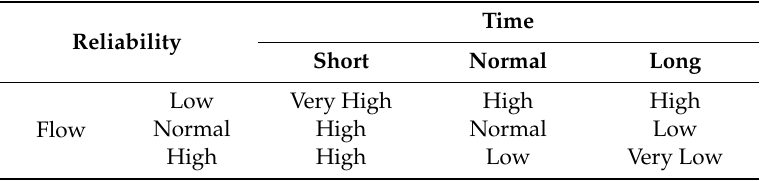
Table 4. Example of fuzzy rule library.